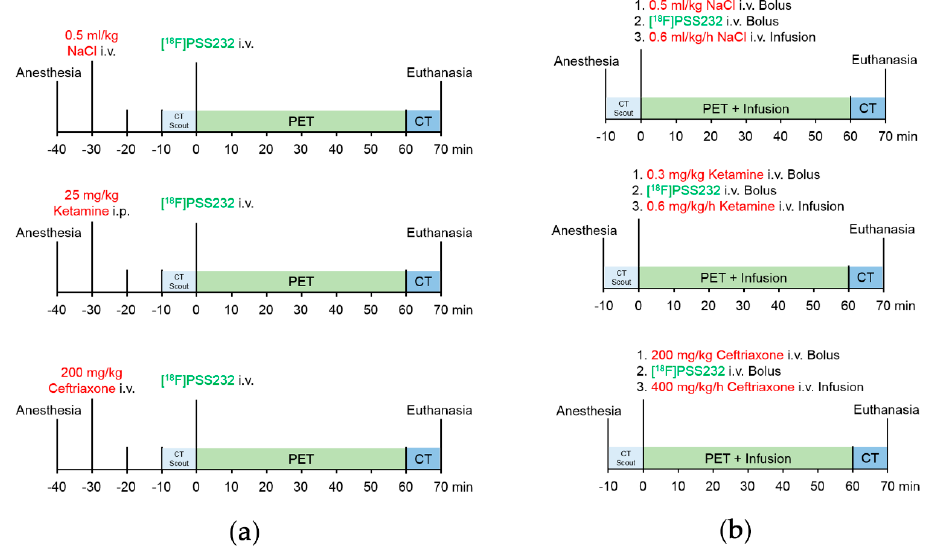
Figure 5. Glutamate challenge study design. ( a ) bolus protocol: anesthetized rats were injected either with 0.5 mL/kg vehicle intravenously (0.9% NaCl i.v.), 25 mg/kg racemic or S-ketamine